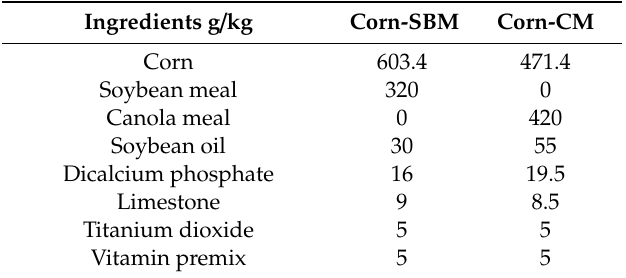
Table 1. Ingredients and composition of the reference (basal)